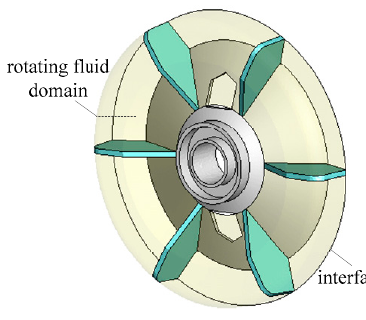
Figure 6. Rotating fluid domain of fan.